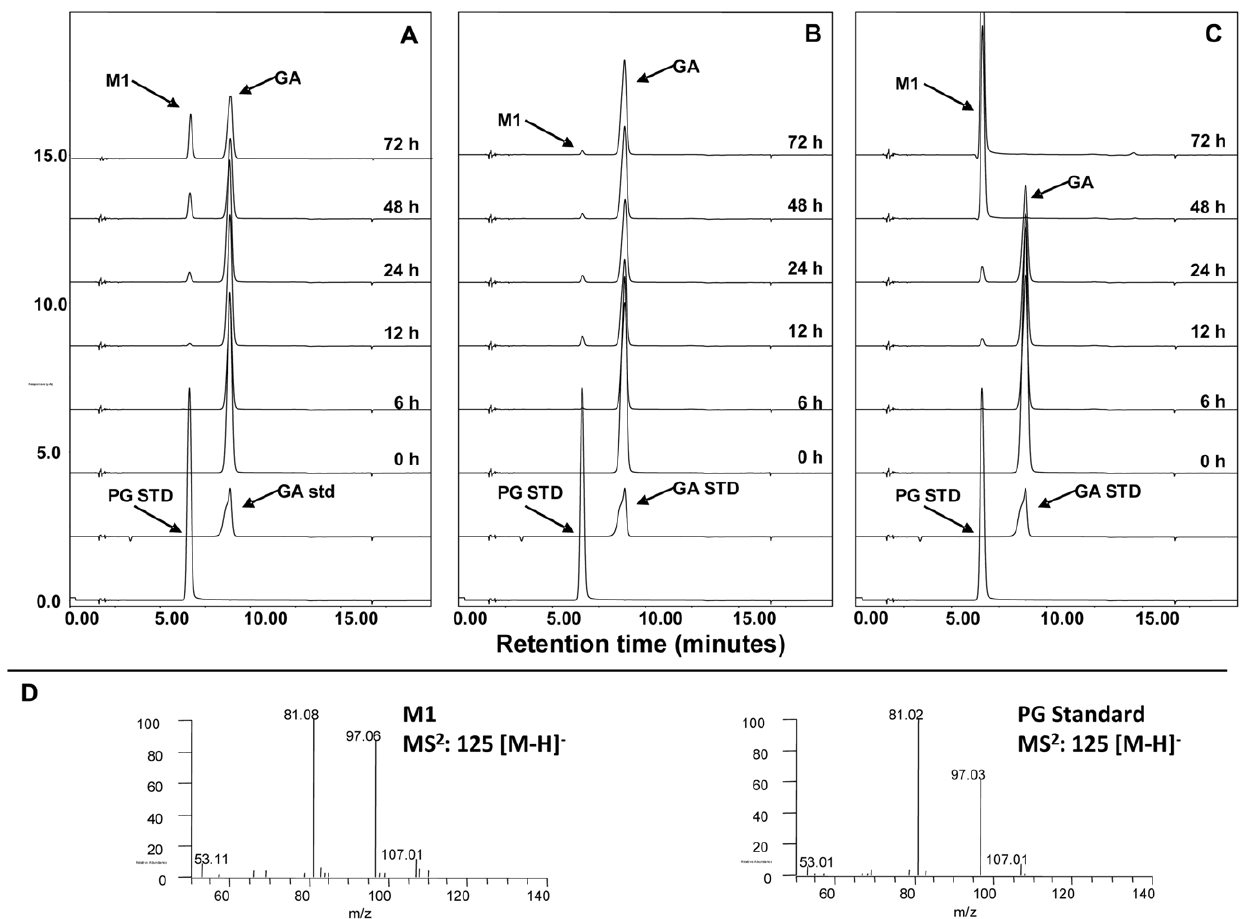
Figure 4. HPLC-ECD chromatograms of microbial metabolites of GA after incubation with human fecal bacteria (A–C); and MS/MS (negative ion) spectra of M1 and authentic PG (D). A, B and C represent the three human volunteers, respectively. GA: gallic acid; and PG: pyrogallol.